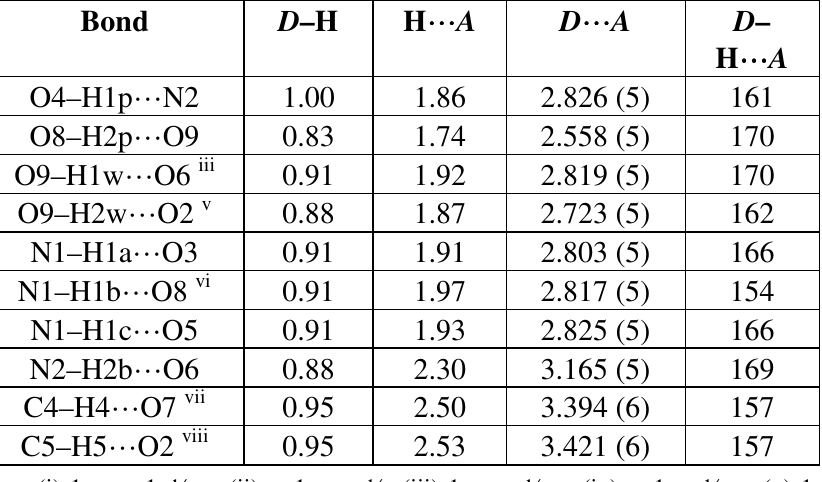
Table 2. Hydrogen-bond geometries (Å, ° ) for 2